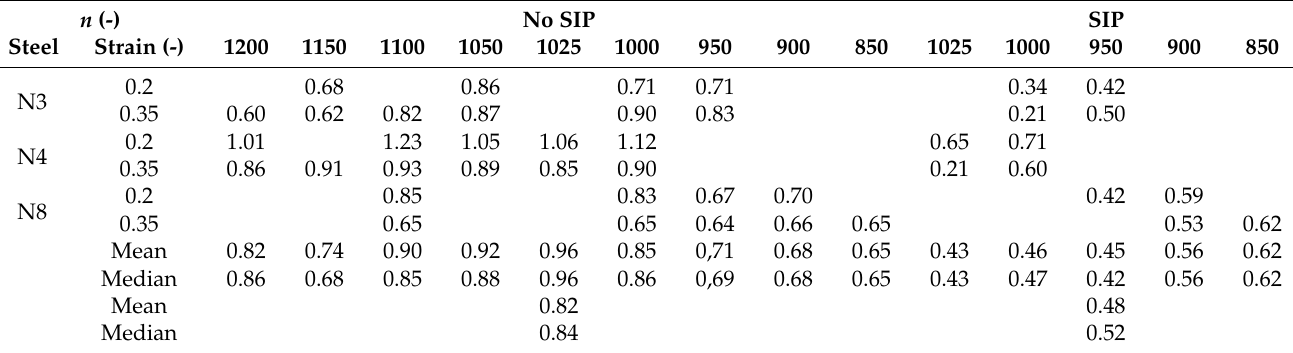
Table 2. Values of the coefficient n in the Avrami equation.